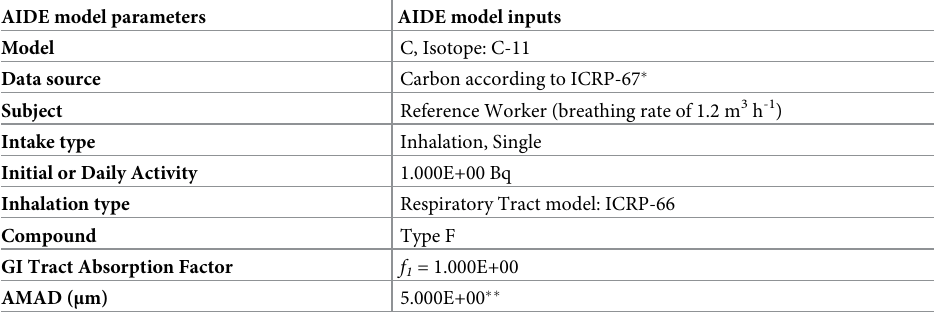
Table 1. Specifications of model parameters and